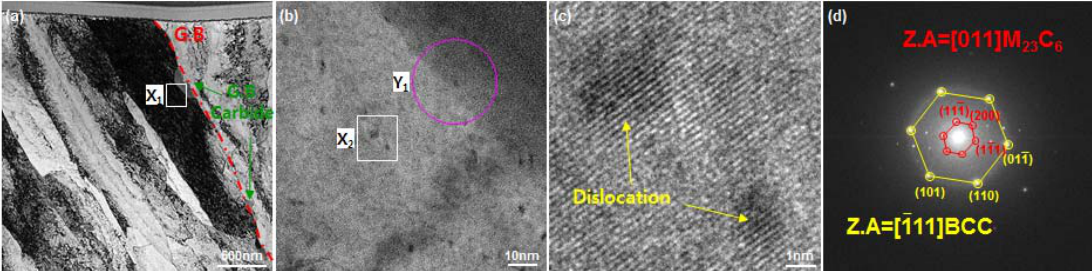
Figure 8. ( a ) TEM micrograph at 700 °C; ( b ) Enlarged micrograph of the region denoted by X 1 ; ( c ) HR ‐ TEM micrograph of the region denoted by X 2 ; ( d ) Diffraction pattern of the region denoted by Y 1 .